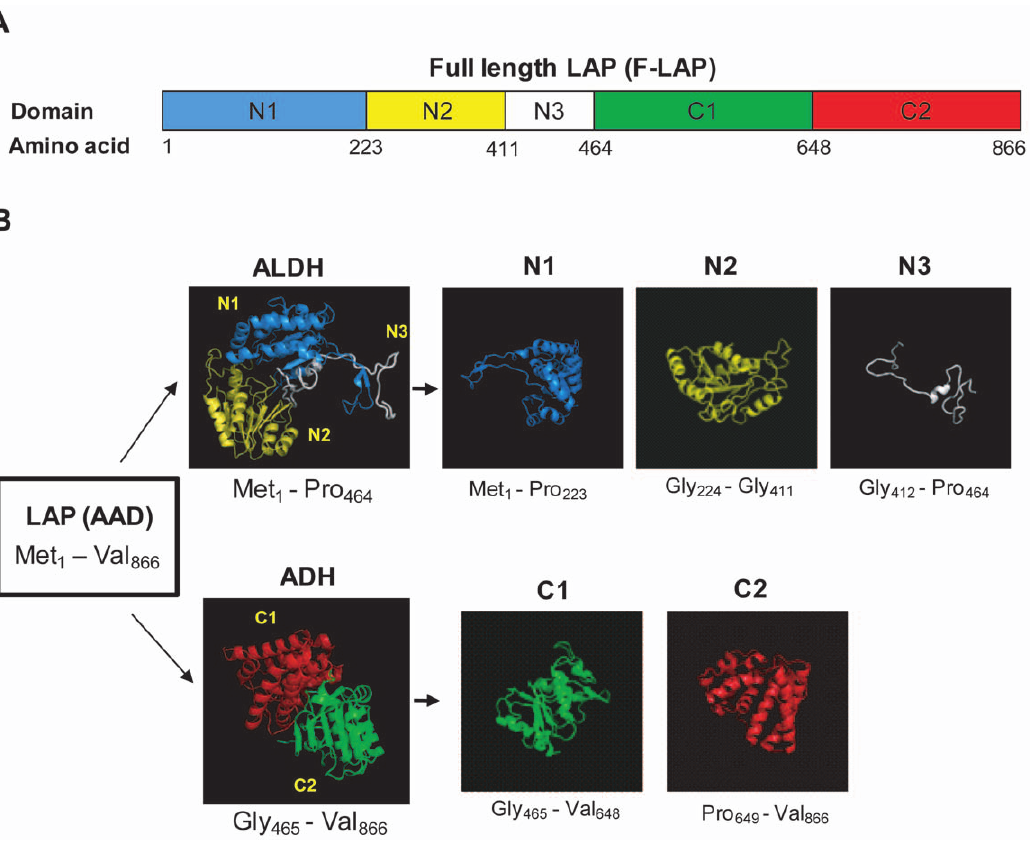
Figure 1. Listeria adhesion protein (LAP) structure predicted from homology modeling (ModBase). ( A ) LAP is an alcohol acetaldehyde dehydrogenase enzyme (AAD; 866 aa) and consists of an N-terminal acetaldehyde dehydrogenase (ALDH) and a C-terminal alcohol dehydrogenase region (ADH). The ALDH and ADH domains are modeled separately. The C terminus also contains an iron binding domain. ( B ) LAP is composed of alpha helices, beta sheets, and loop structures. N-terminal ALDH was determined to be composed of 3 independent subdomains: N1 (Met 1 –Pro 223 ), N2 (Gly 224 –Gly 411 ), and N3 (Gly 412 –Pro 464 ). Similarly, C-terminal ADH was defined as having 2 independent subdomains: C1 (Pro 465 –Val 648 ) and C2 (Pro 649 –Val 866 ). N3 is a loop region that connects the LAP N- and C-terminus and is thought to be incapable of independent Hsp60 interaction; hence, this region was cloned and expressed in conjunction with the C1 subdomain. The N1, N2, N3, C1, and C2 subdomains are colored in blue, yellow, white, green, and red, respectively. Also using the same color scheme, the bottom panel represents the full LAP sequence and partitioned into the colored subdomains (boxed and labeled by the ending amino acid positions for each